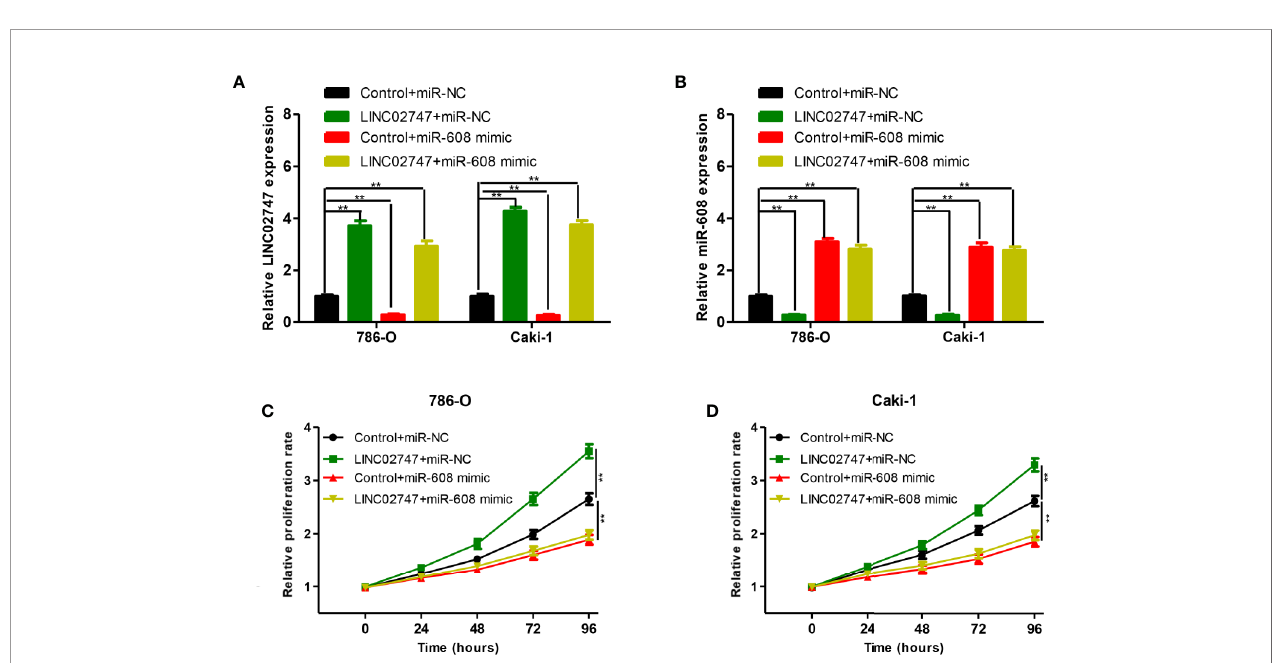
FIGURE 7 | qRT-PCR analysis of LINC02747 (A) and miR-608 (B) expression in the786-O and Caki-1 cells transfected with Control+miR-NC, LINC02747+miR-NC, Control+miR-608 mimic, or LINC02747+miR-608 mimic. The 786-O (C) and Caki-1 (D) cells were transfected with Control+miR-NC, LINC02747+miR-NC, Control +miR-608 mimic, or LINC02747+miR-608 mimic., and cell proliferation in each group was detected by CCK-8 assays. (*** P < 0.001, ** P < 0.01, * P < 0.05).